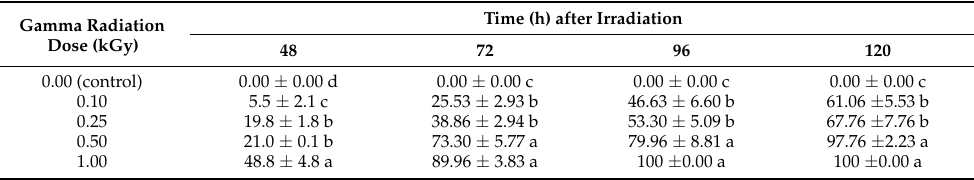
Table 1. Mortality percentage of S. oryzae adults after exposure to different doses of gamma radiation at different times.